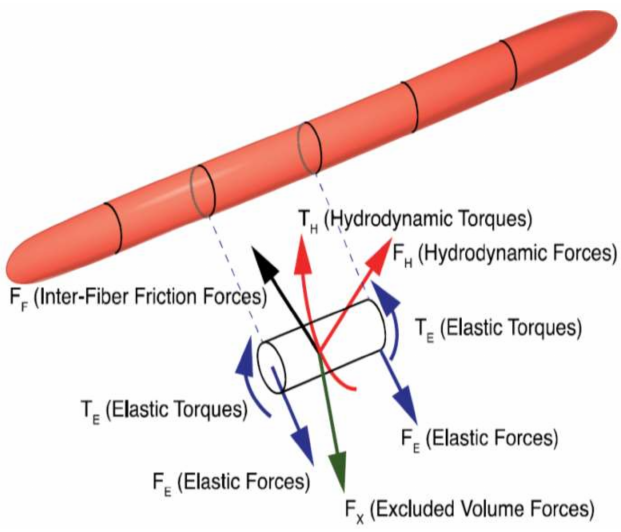
Figure 3. Discretization of a fibre as a chain of elements, corresponding forces, and momentum balance for an individual element [50].